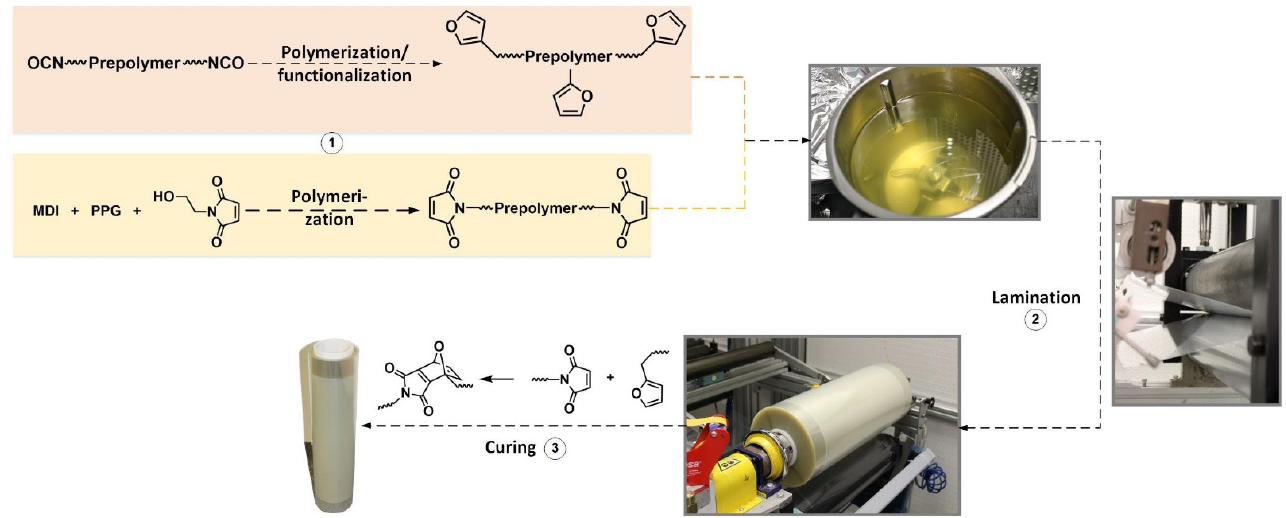
Figure 6. Overview of the individual steps in laminate production. Step 1 represents the production of the adhesive, step 2 the lamination of the PET film with the LDPE film, and step 3 the curing of the adhesive.